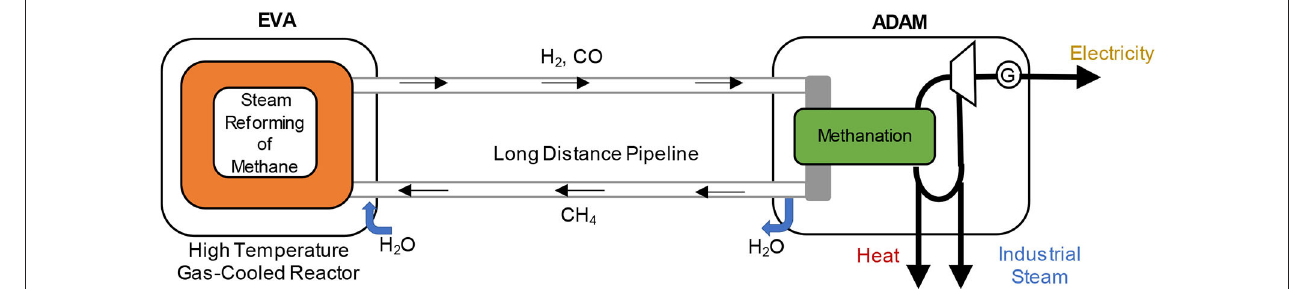
FIGURE 3 | Schematic representation of the processing pathways for producing gases such as CH 4 and H 2 from carbon sources and renewable electricity (original drawing based on concepts from Götz et al., 2016).